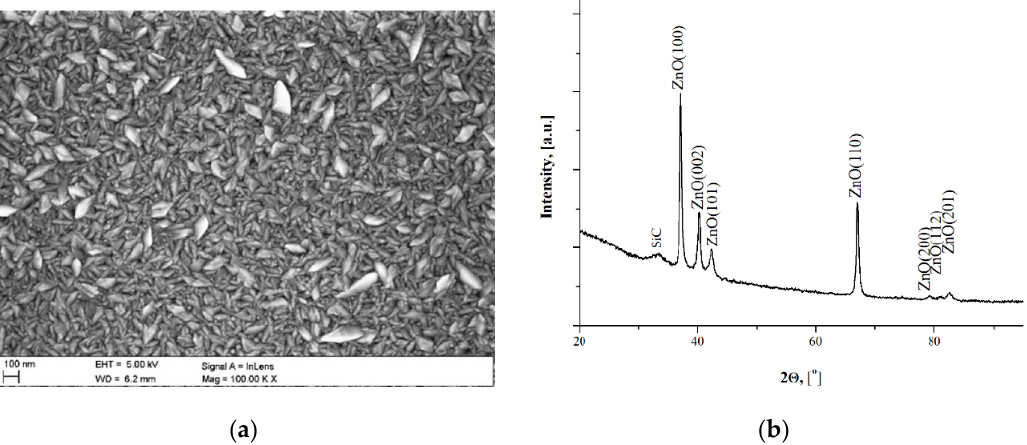
Figure 2. Oxide layer ZnO characterization ( a ) surface morphology scanning electron microscopy (SEM); ( b ) X-ray energy dispersive plot.